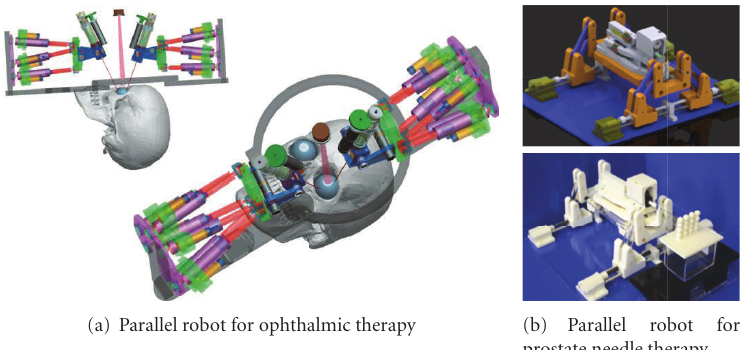
Figure 2: (a) The design for a dual-arm robot for use in ophthalmic surgery. Two parallel robots are perched upon a fixation halo, and each can hold modular instruments [5]. (b) The 4-DOF parallel platform manipulator is integrated with a 3-DOF needle driver module to provide 7-DOF needle motion for prostate interventions